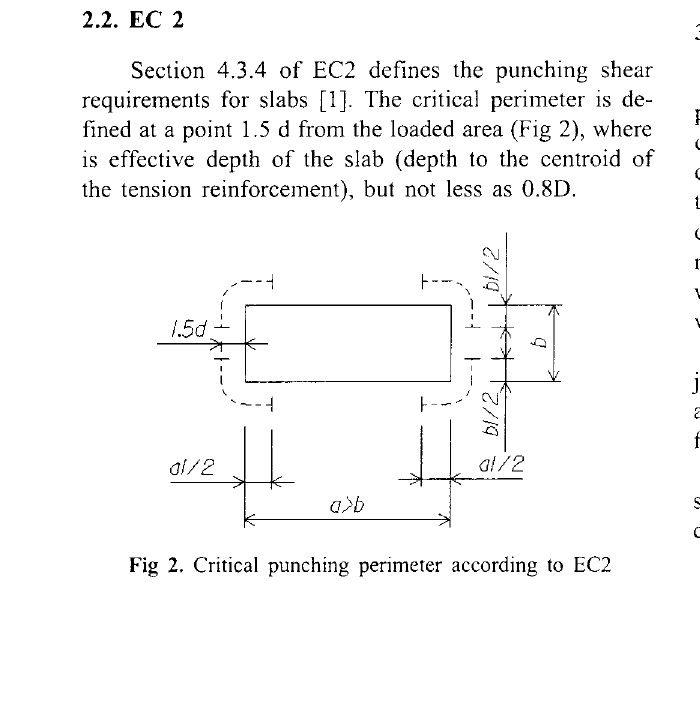
Fig 1. Critical punching area according to ACT 318